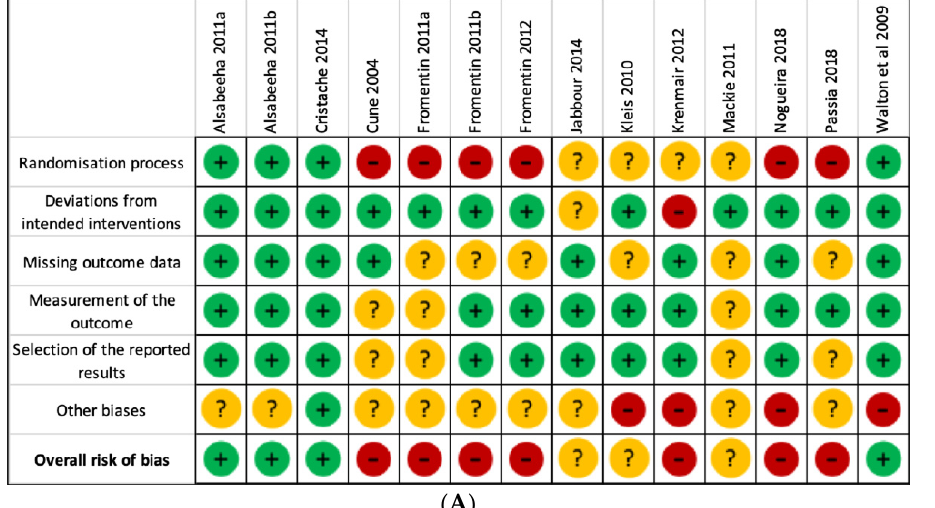
( B ) Figure 4. Risk of bias summary: authors’ assessment of each risk of bias item for each included clinical ( A ) and in vitro study ( B ). 3. Results and Discussion According to the aim of this SR, the results are presented in four parts: the initial retention of BAS and CAS, the retention loss and wear of AS correlated to the prosthodontic maintenance; the influence of implant parameters (iii) and experimental conditions on the retention, wear, and maintenance. Finally, paragraph (v) exposes the limitations of our study and, in particular, the difficulty of comparing studies directly because of the variability in their protocols and reported results. 3.1. Initial Retention of BAS and CAS Retention is defined as the maximum force developed until dislodgement of the denture from its mucosal and/or implants bearing surfaces. It represents the mechanical resistance to displacement along the insertion axis opposite to denture insertion [27]. Retention must be high enough to limit unwanted movements of the removable prosthesis while inducing reasonable lateral forces on the implant, whatever its size or angulation [19]. The adequate and satisfactory retention force for each patient remains challenging to assess [4], the minimum commonly accepted lying between 5 and 20 N while being maintained over time [11,13,14,27]. Some authors suggested that 5–7 N are sufficient for 1-IRMO [13,14,32,33], and other investigators proposed 10 N [33] or 20 N for 2-IRMO [11]. In vitro studies showed that most AS in 1 or 2-IRMO could reach this acceptable range. BAS show retention forces in agreement with manufacturers’ data, in the range of 2–16 N for 1-IRMO. However, regarding CAS for 1-IRMO, a wide range of retention